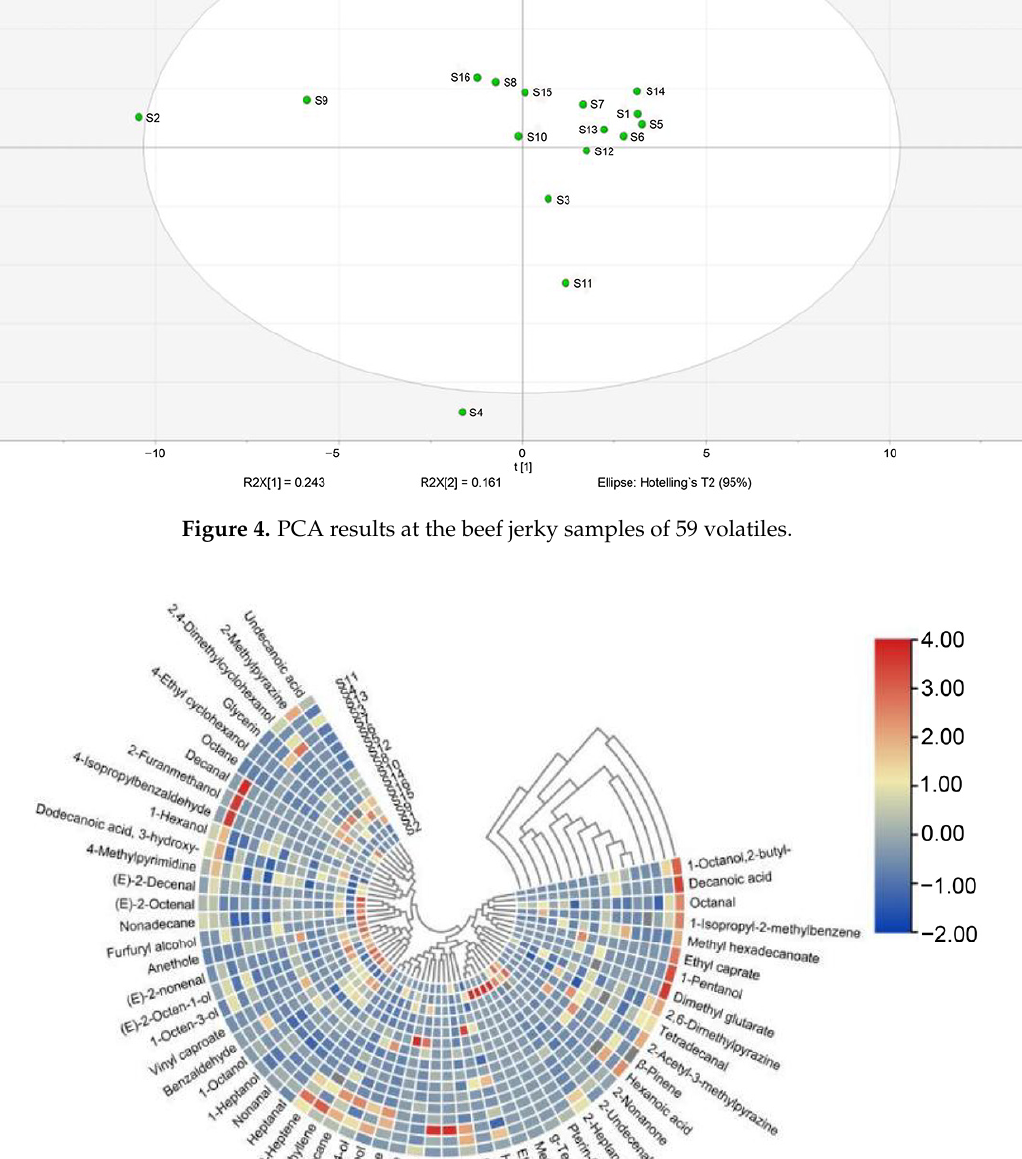
Figure 5. Heat map cluster analysis of the volatile components with the Euclidean distance and McQuitty’s criterion.